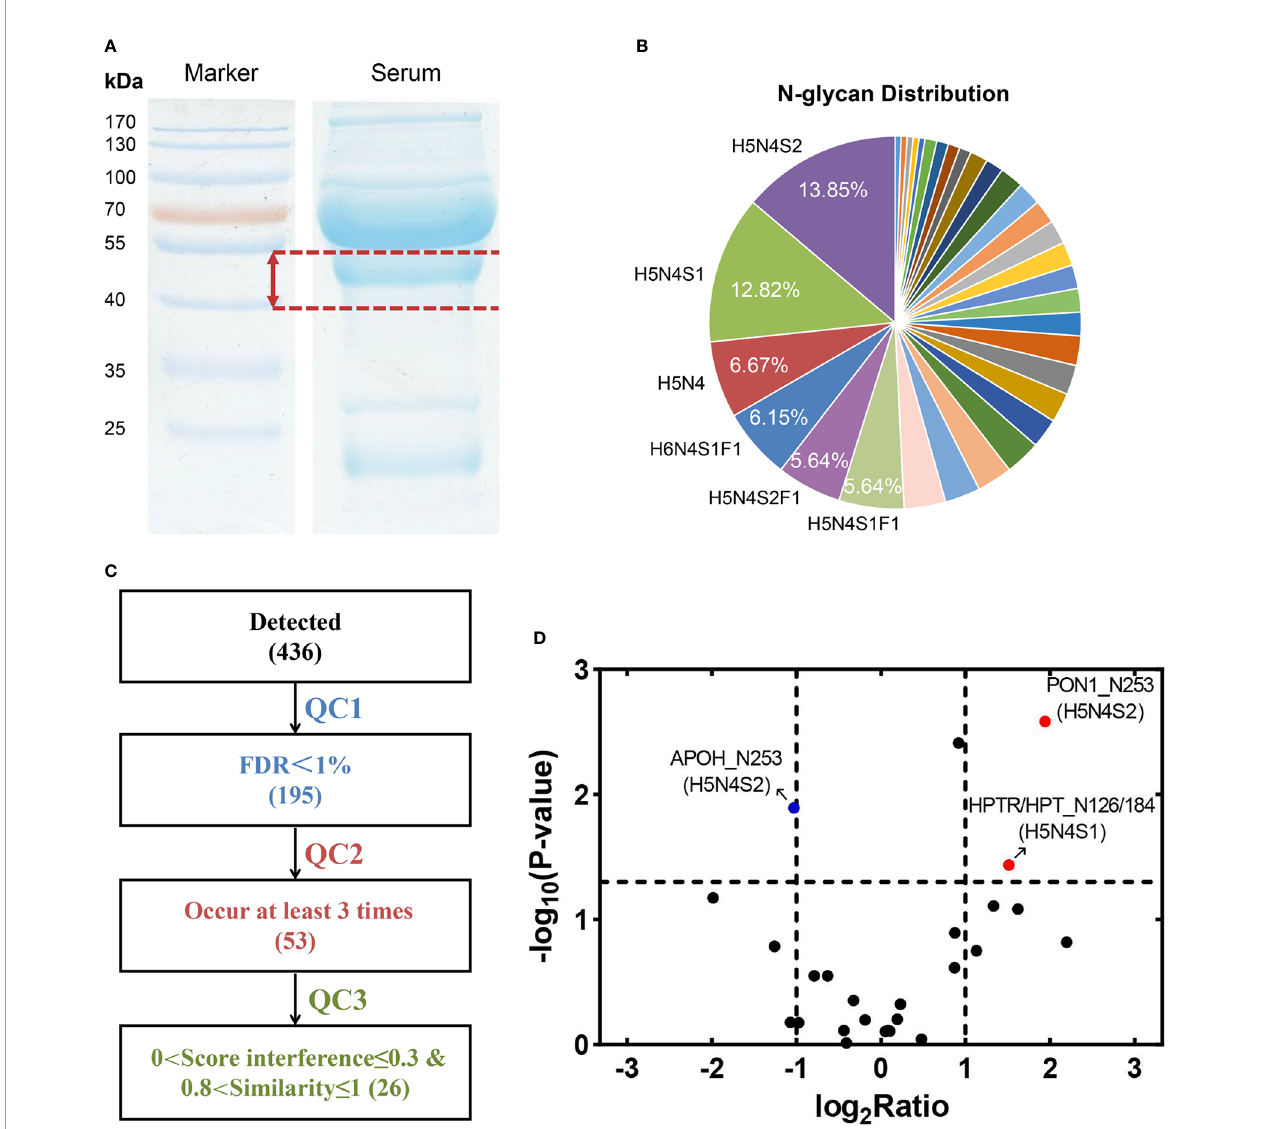
FIGURE 2 | (A) Equal volumes of serum were acquired to separate 40-kDa band. (B) A total of 195 N-linked glycopeptides were identi fi ed, belonging to 33 kinds of glycan compositions. (C) Based on four biological repeats (each pooled from fi ve randomly selected individuals), 26 N-linked glycopeptides appeared more than three times (QC2) and passed strict screening criteria (QC3) were considered. (D) Three glycopeptides corresponding to APOH, PON1, and HPTR/HPT were changed signi fi cantly in AFP-negative HCC compared with LC